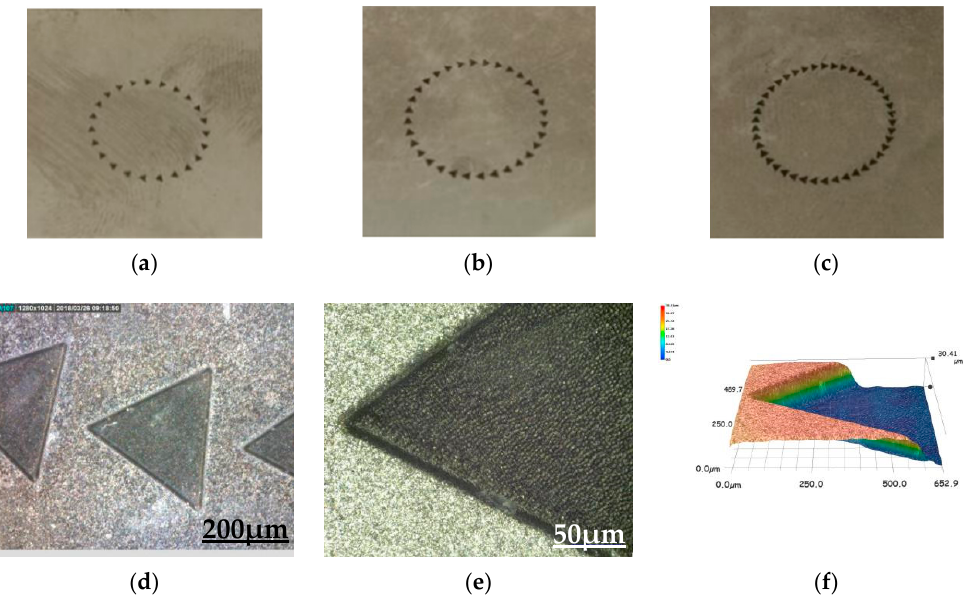
Figure 1. Triangular micro-texture arrays obtained by laser processing and micro-morphology of triangular taken by DINO-LITE microscope and ultra-high accuracy microscope. ( a ) Triangular texture with an area occupancy ratio of 7%; ( b ) Triangular texture with an area occupancy ratio of 10%; ( c ) Triangular texture with an area occupancy ratio of 13%; ( d ) Triangular texture microscopic morphology with a scale of 200 µ m; ( e ) Triangular texture microscopic morphology with a scale of 50 µ m; ( f ) Triangle texture 3D morphology.